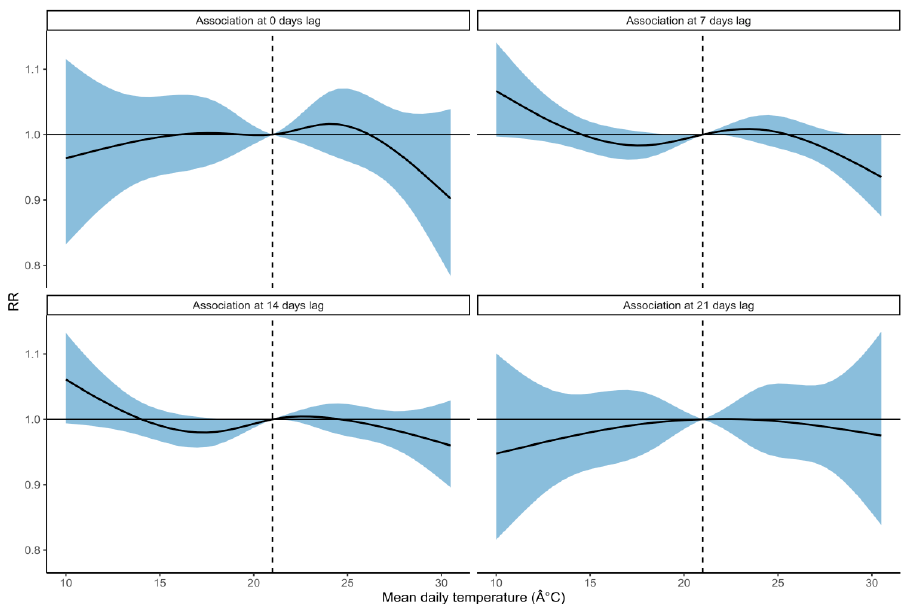
Figure 4. The association between mean daily temperature and pneumonia hospital admissions at different days of lag. The solid curves are the predicted relative rates (RR), and the shaded regions are the 95% CI. The median mean daily temperature (21 °C) is indicated by the dashed vertical line and is used as the reference value against which the RR for other temperatures is compared.